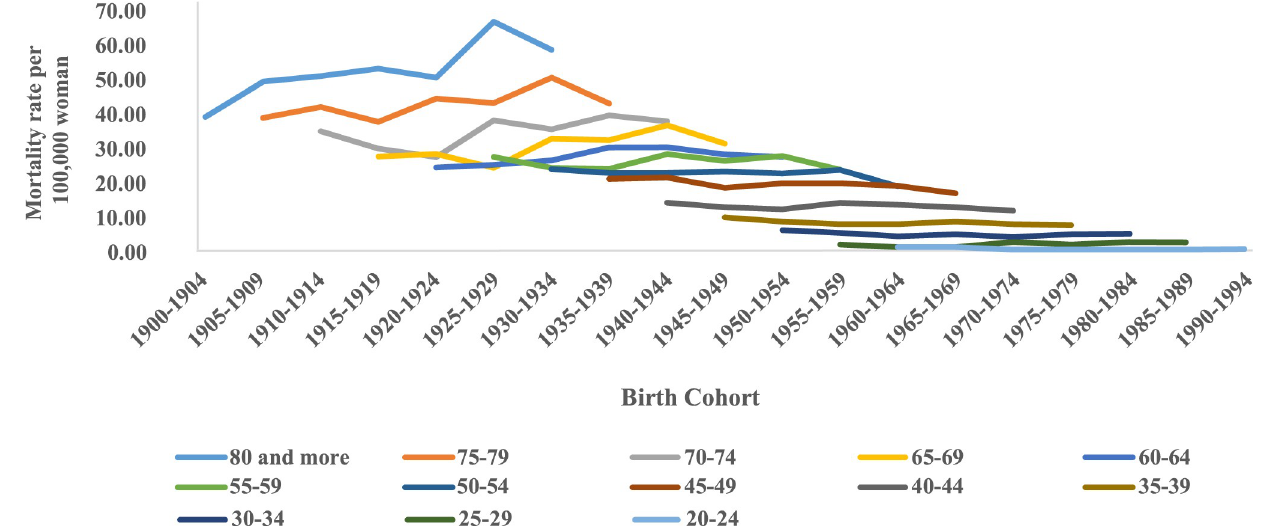
Fig 4. Corrected mortality rates for cervical cancer according to birth cohort and age group in northeastern Brazil, 1980–2014.